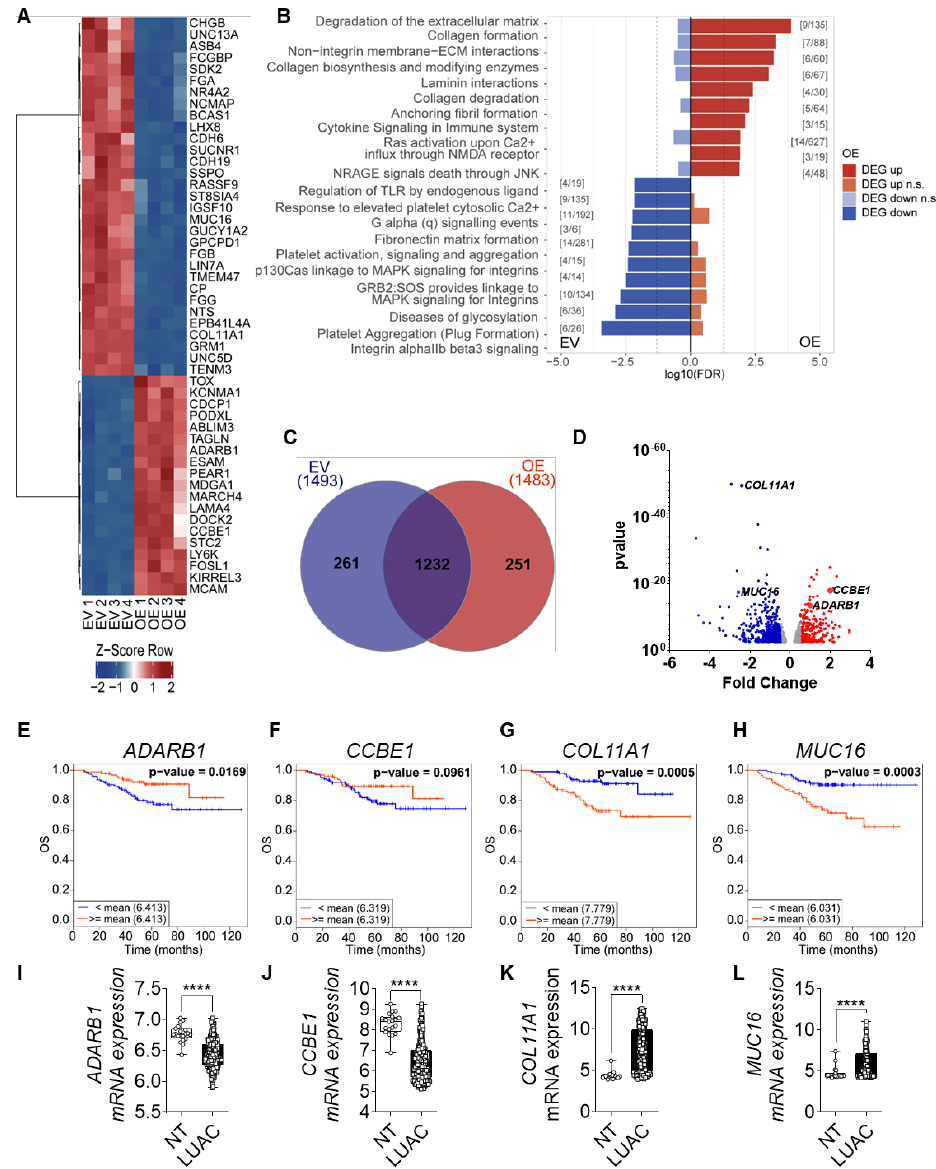
Figure 5. FGF14 overexpression impacts gene expression profile of tumor cells. ( A ) Heatmap of top 50 most significant di ff erentially expressed genes (DEGs) for each contrast (sorted by smallest adjusted p- value). ( B ) The DEGs, split into up and downregulated genes, a gene set enrichment analysis was performed using KEGG Orthology-Based Annotation System (KOBAS). The graph represents the top 10 gene sets or pathways enriched for up- or downregulated genes of one database (dashed line: p- value = 0.05). The graph only shows pathways that were not significant for both directions (up and down). Significant gene set enrichment was defined by the false discovery rate (FDR). ( C ) Venn diagram of DEGs using InteractiVenn [36]. ( D ) Volcano plot: bottom track = p- value based definition of a DEG (less stringent, only for comparison). ( E – H ) Kaplan – Meier estimate of OS among the Okayama patients dataset with LUAC classified according to the mRNA expression levels of CCBE1, ADARB1, COL11A1 , and MUC16 as either high (above the mean value of mRNA levels, red) and low (below the mean value of mRNA levels, blue). ( I – L ) mRNA expression level of in LUAC samples from the same study compared with non-tumor tissue. Data was obtained from CANCERTOOL. Data are presented as mean ± standard error of the mean using Student’s t -test. p -values ≤ 0.05 were considered statistically significant for all analyses **** p ≤ 0.0001.